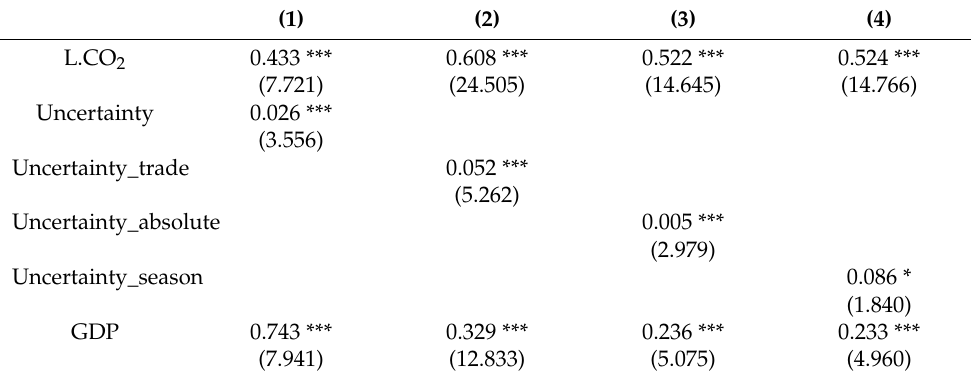
Table 7. Robustness test—middle 80%